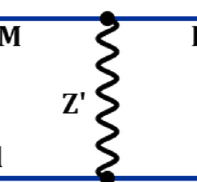
Fig. 9 Dark matter relic abundance as a function of dark matter mass m DM for various gauge couplings g R (left) and Z (cid:2) boson masses (right). For simplicity, we set m Z (cid:2) = 10 TeV (left) and g R = 0 . 1 (right). Horizontal red and blue lines represent WMAP [78] relic density constraint 0 . 094 ≤ (cid:20) DM h 2 ≤ 0 . 128 and